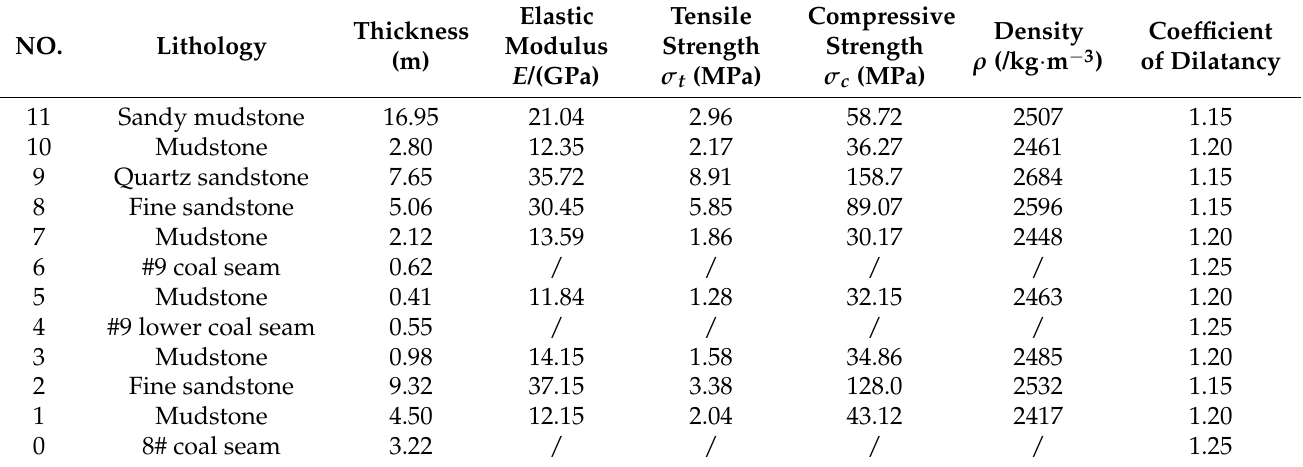
Table 1. Mechanical parameters of roof strata in the conveyor roadway of the 360,805 working